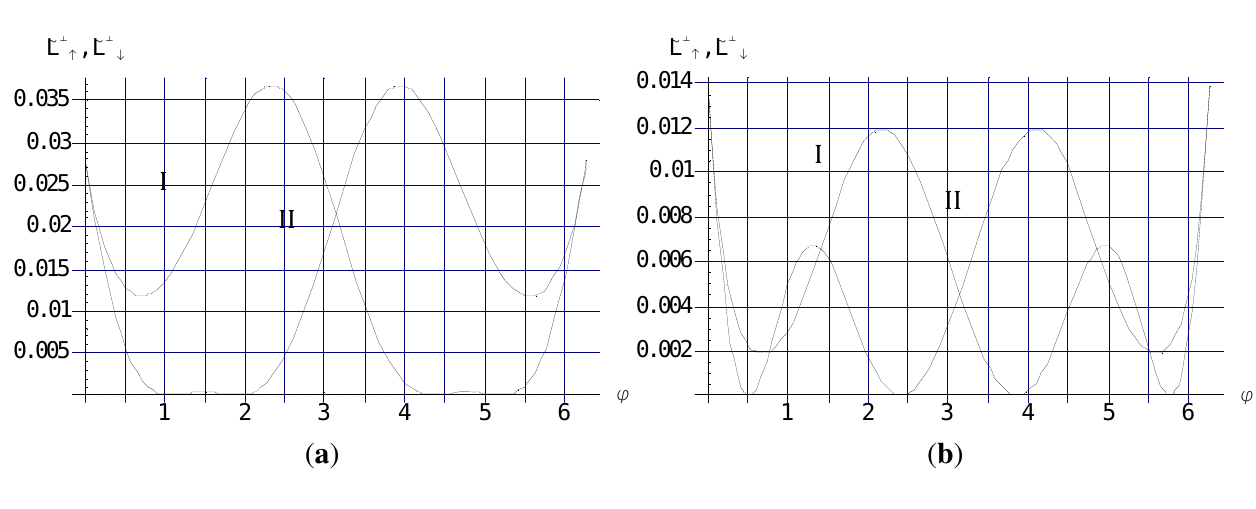
Figure 5. ˜ L ⊥ (curve II) versus ϕ (in radian). ( a ) for ka = 0 . 5 , and ( b ) for (curve I) and ˜ L ⊥ ↓ ↑ ka = 1 according to Equations (40) and